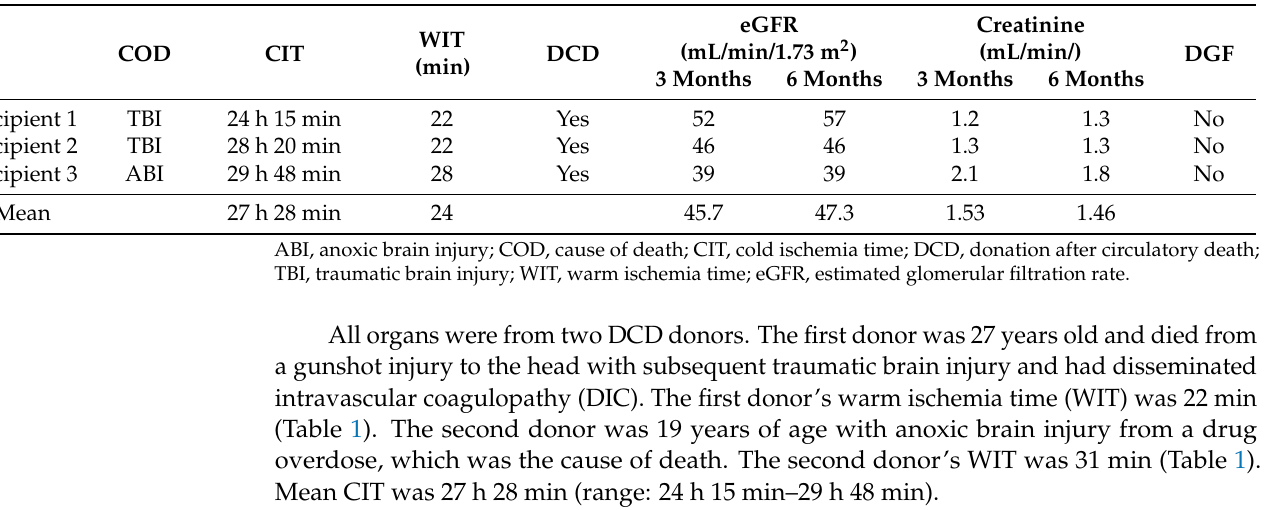
Table 1. Donor characteristics and recipient